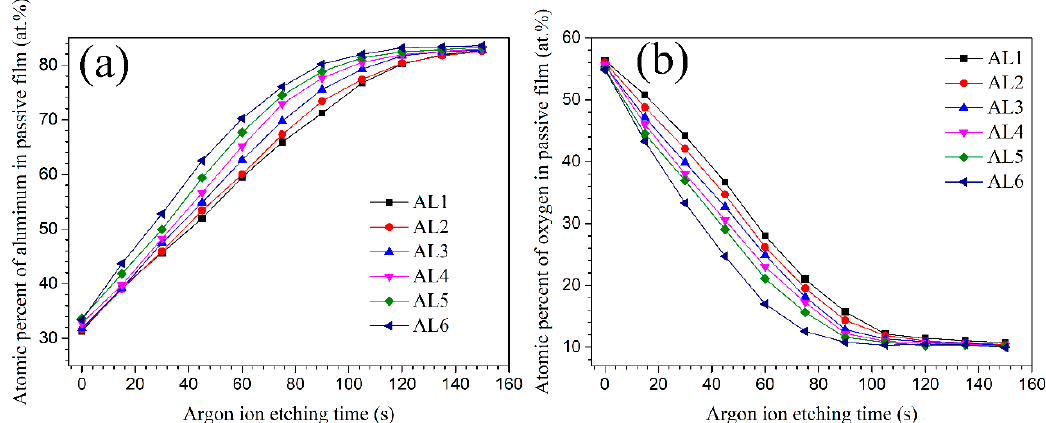
Figure 12. XPS depth profile of element strength of Al and O for passive film formed on sintered 7075 alloys, ( a ) Al2p, ( b ) O1s.